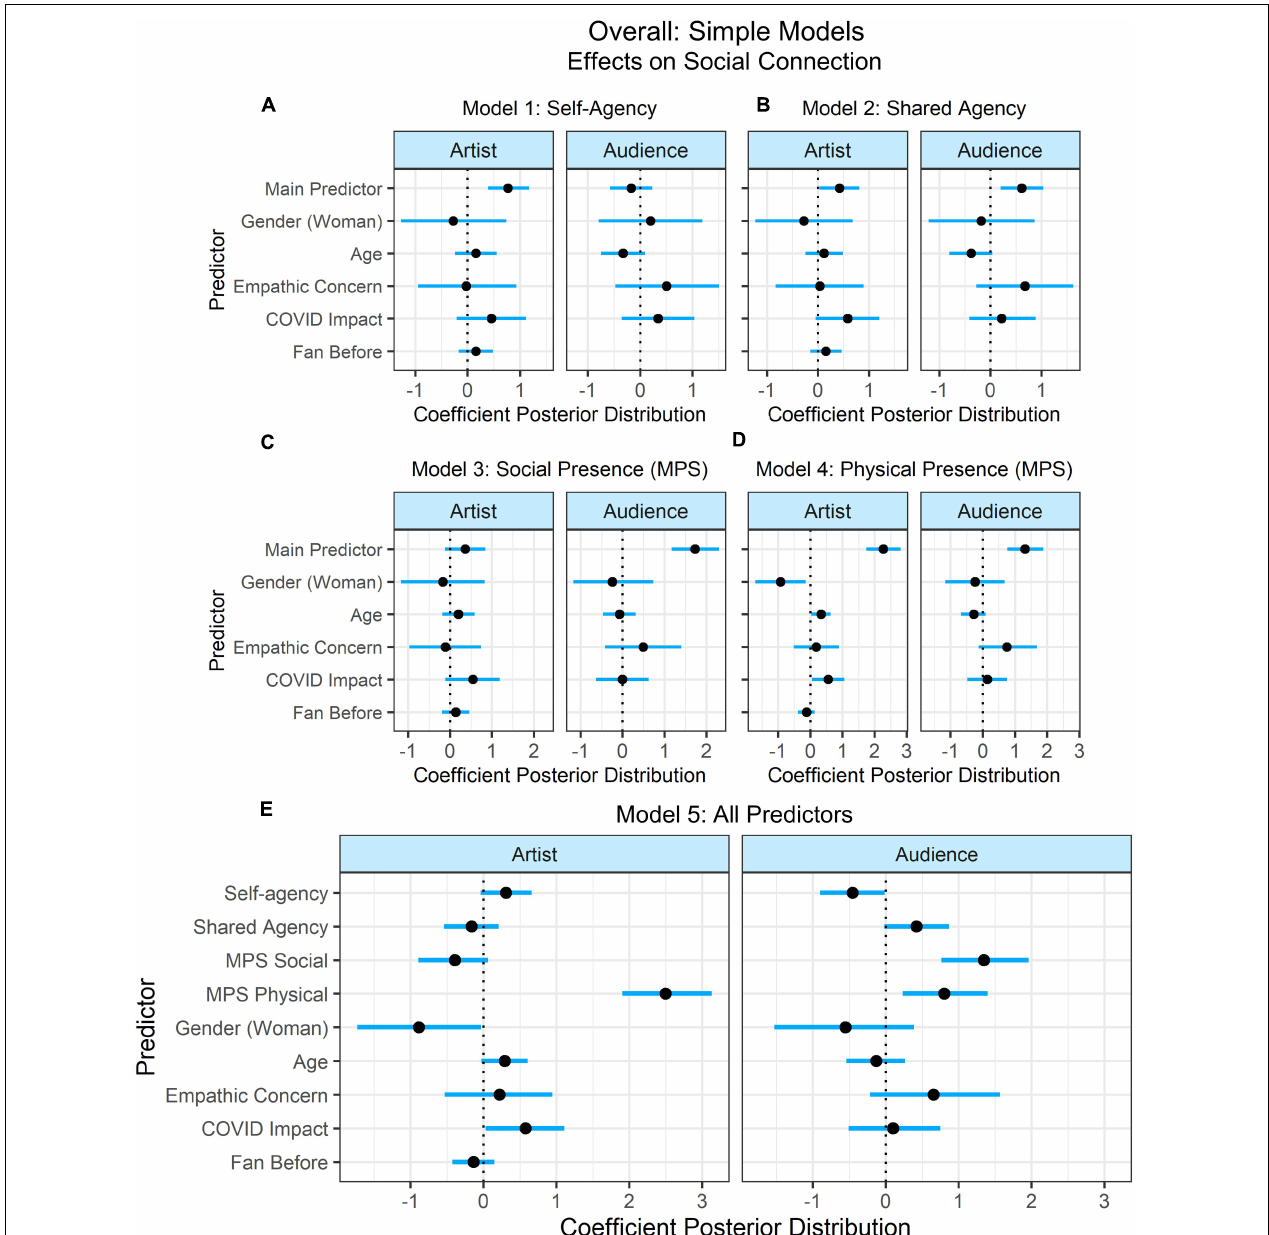
FIGURE 8 | Overall simple models’ predictor coefficient estimates and 90% credible intervals using data from all concerts to determine the effects on social connection to the artist (left) and audience (right). Five models were fit to examine the individual contribution of the variables of interest: (A) Self-agency, (B) Shared Agency, (C) Social Presence, and (D) Physical Presence, and the combined effects of all predictors (E) . Lines indicate the 90% credible intervals (i.e., there is a 90% posterior probability that the coefficient of the predictor lies in that range). Credible intervals not intersecting 0 indicate that there is at least a 90% probability that the effect of that predictor on social connection is positive or